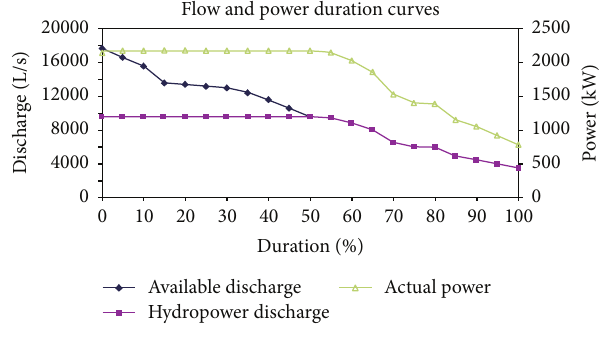
Figure 6: FDC and power curve.